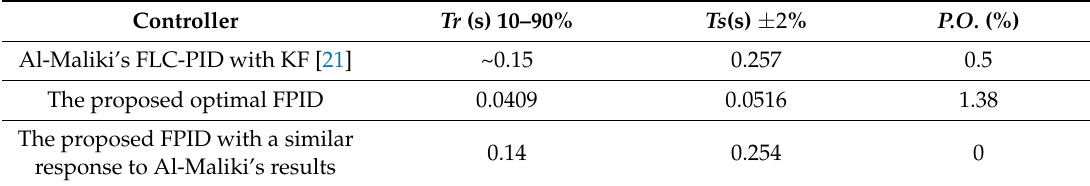
Table 8. Response performance of different